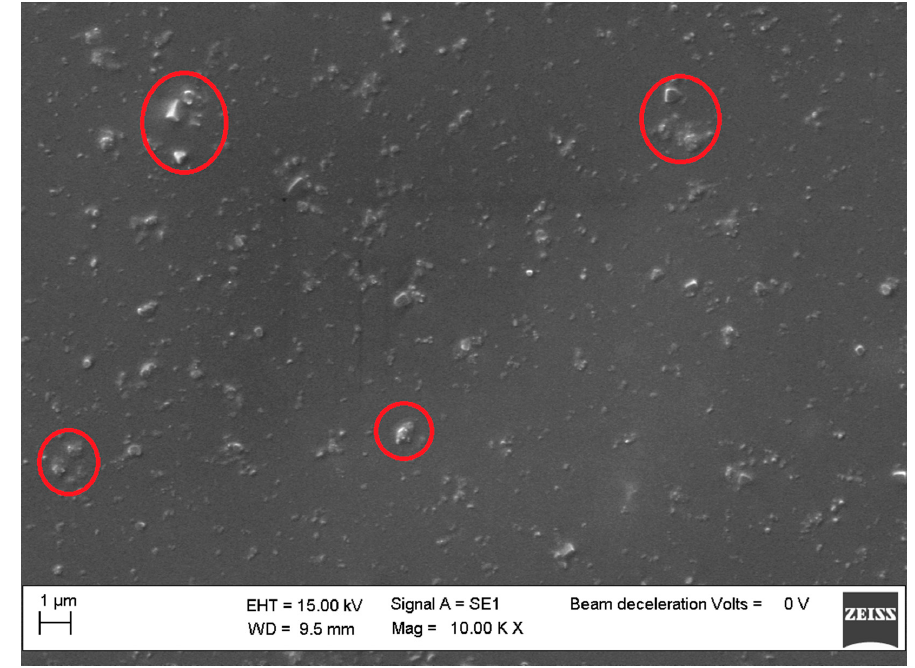
Figure 12. SEM micrographs of sample 1 .